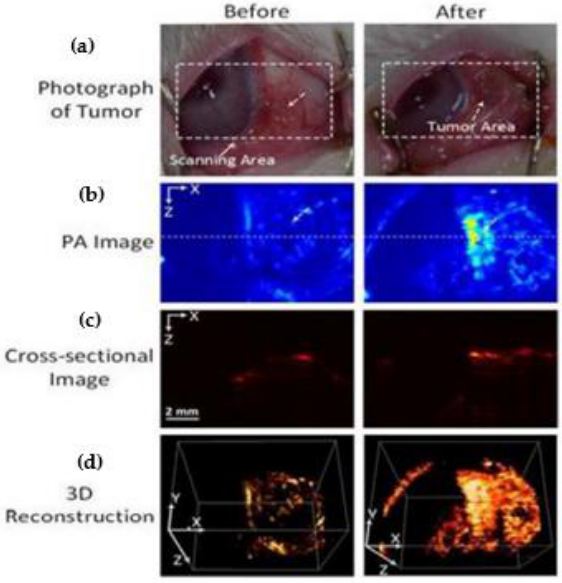
Figure 8. Intratumoral injections of Dox-Fu@AuNPs were performed in rabbit eyes. ( a ) On the top panel, photographs of the tumor are visible before and after the injections; ( b ) photoacoustic images ( b ) disclosed enhanced signal after the injection ( p < 0.05); ( c ) cross-sectional images; ( d ) 3D reconstructions [104]. Kim H., Nguyen V. Phuc, Manivasagan P., Jung M. Jung, Kim S. Won, Oh J., Kang H. Wook Doxorubicin-fucoidan-gold nanoparticles composite for dual chemo-photothermal treatment on eye tumors. Oncotarget. 2017; 8: 113719–113733. Retrieved from